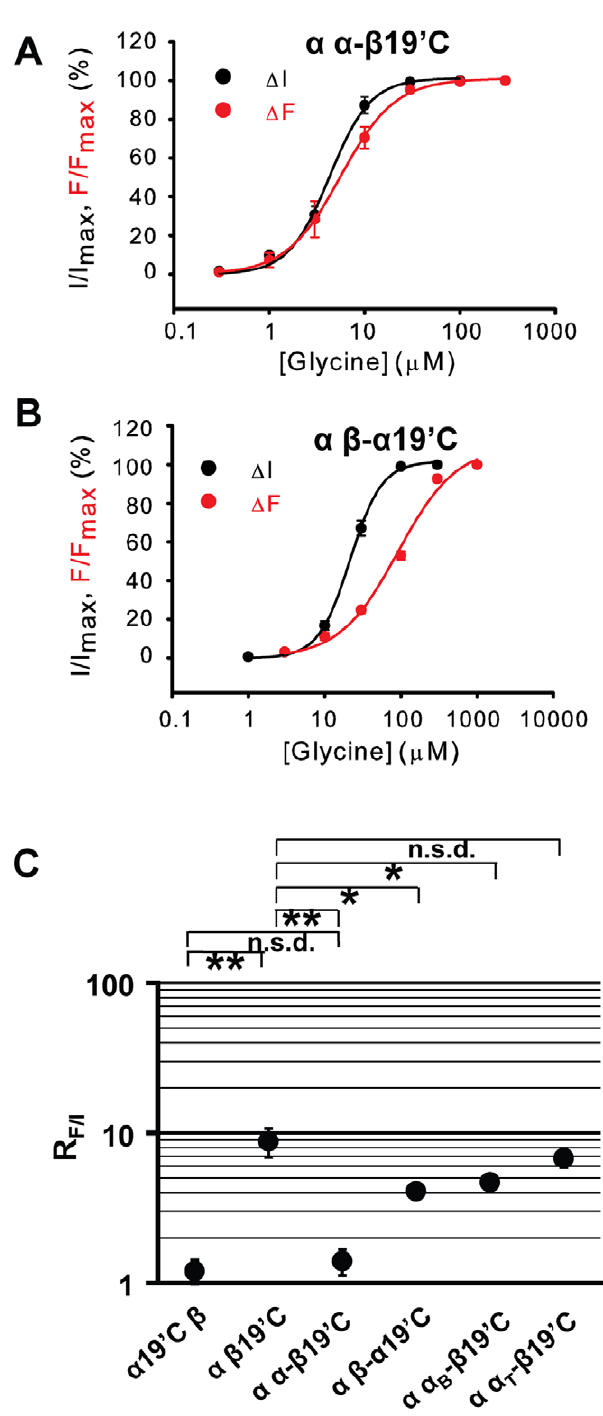
Figure 5. VCF of chimeric a 1 b GlyRs. Averaged, normalized glycine concentration-response curves of current and fluorescence of a a - b 19 9 C and a b - a 19 9 C GlyRs are shown in (A) and (B), respectively. (C) The R F/I s (the EC 50 of fluorescence divided by the EC 50 of current) of the a 19 9 C b , a b 19 9 C, a a - b 19 9 C, a b - a 19 9 C, a a B - b 19 9 C and a a T - b 19 9 C GlyRs are plotted. ( * p , 0.05; ** p , 0.01; n.s.d. not significantly different, using the Student’s